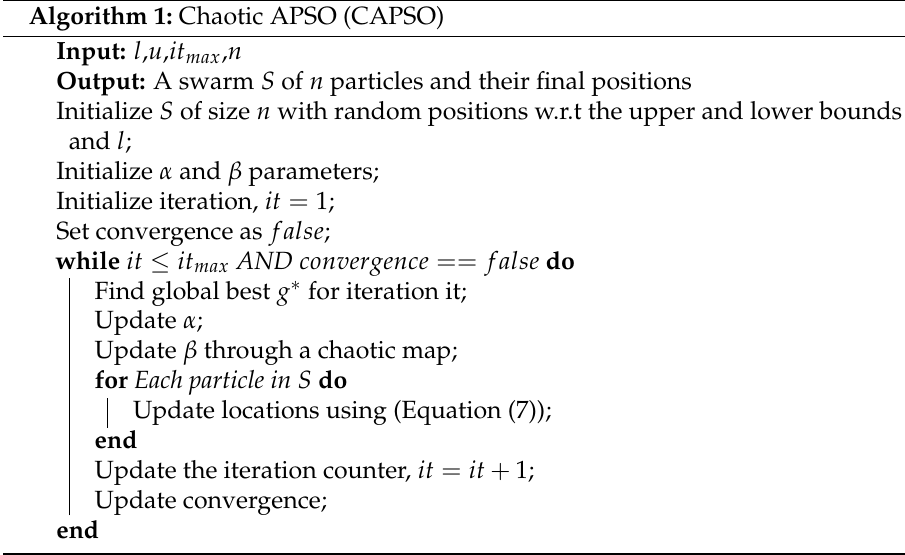
Algorithm 1: Chaotic APSO